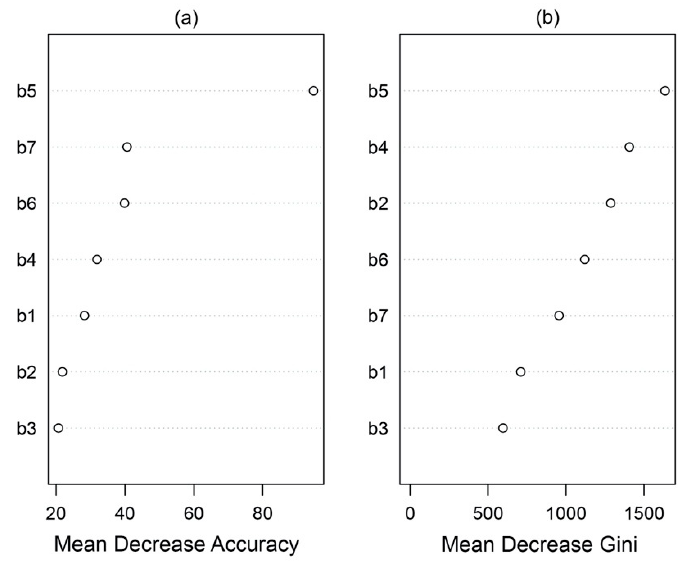
Figure 6. The variable importance of the random forests classifier by ( a ) Mean Decrease Accuracy and ( b ) Mean Decrease Gini.